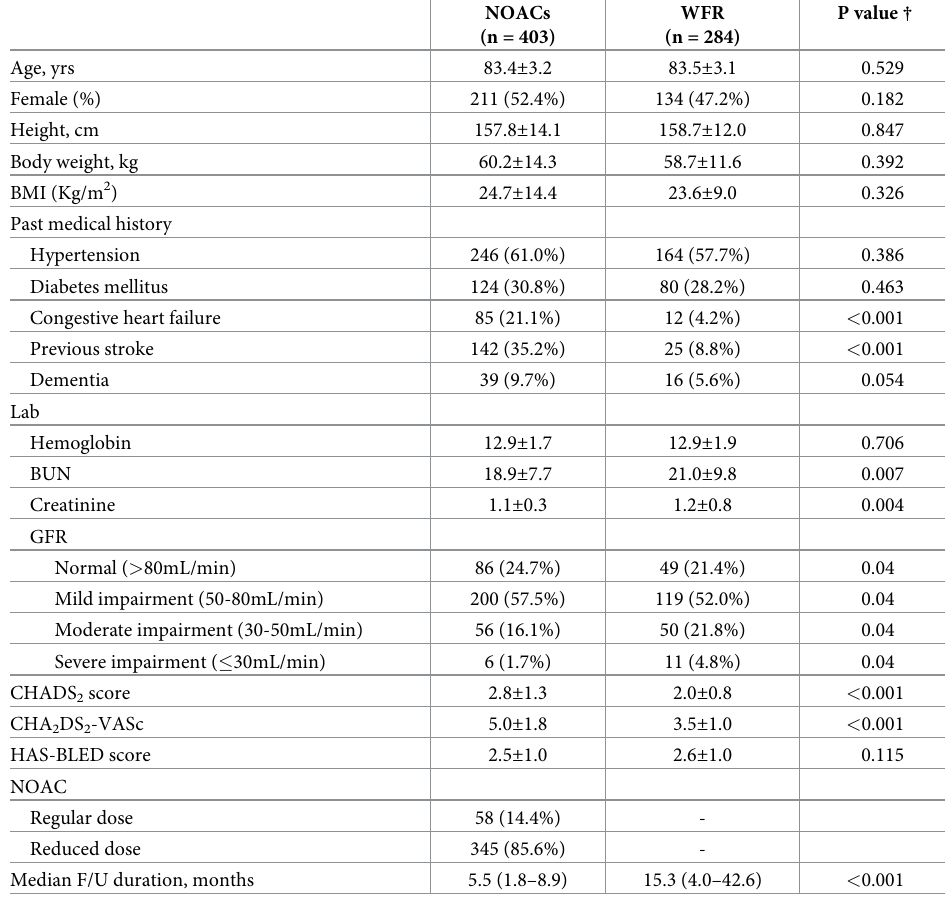
Values are presented as mean ± SD, as n (%), or median (interquartile range). WFR = warfarin † P value between NOACs and warfarin